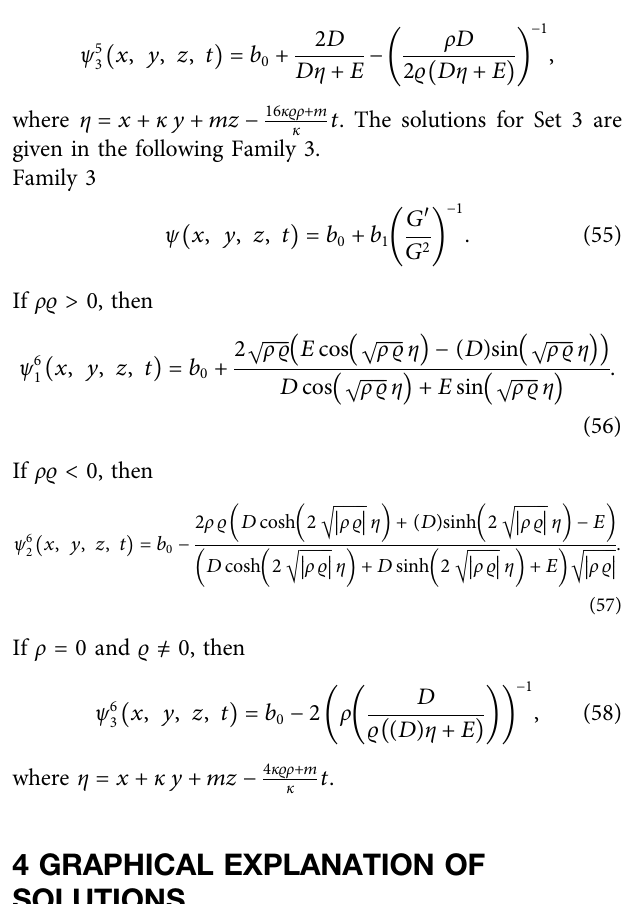
FIGURE 6 | ψ 4 2 ( x , y , z , t ) : κ = 2, D = 6, rest of constants = 1